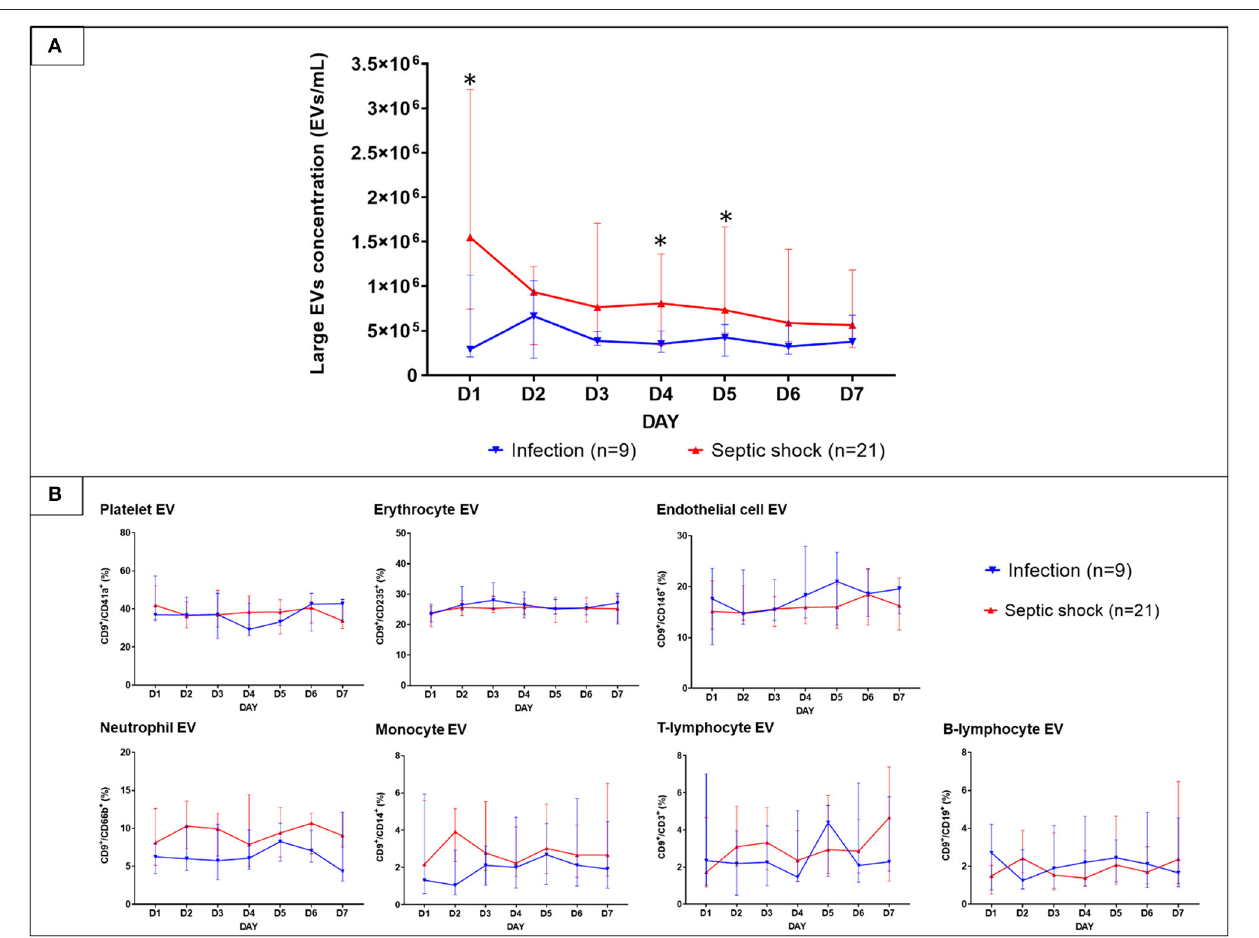
FIGURE 4 | The longitudinal trends of large EVs concentration and the proportion of each subtype in patients with septic shock and non-sepsis infection. EVs were isolated from PFP samples collected daily for seven consecutive days after hospital admission. Large EVs concentration (A) and their proportion (B) sorted by subtypes were quantified by the imaging flow cytometry analysis. The results were illustrated in line graphs with error bars using median and IQR. The comparison of the results between septic shock and non-sepsis patients were performed with Wilcoxon rank sum tests. * p -value from Wilcoxon rank-sum test < 0.05. EVs, extracellular vesicles; IQR, interquartile range; PFP, platelet-free